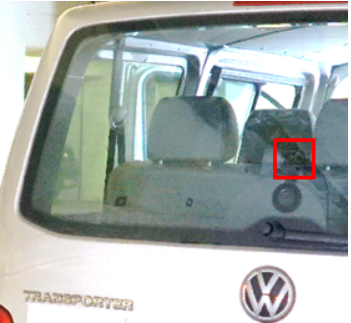
Figure 6: View onto the rear window pane of the test car. The rear environment camera (red rectangle) is looking at the area behind the car. Image brightness increased strongly for better visualization.